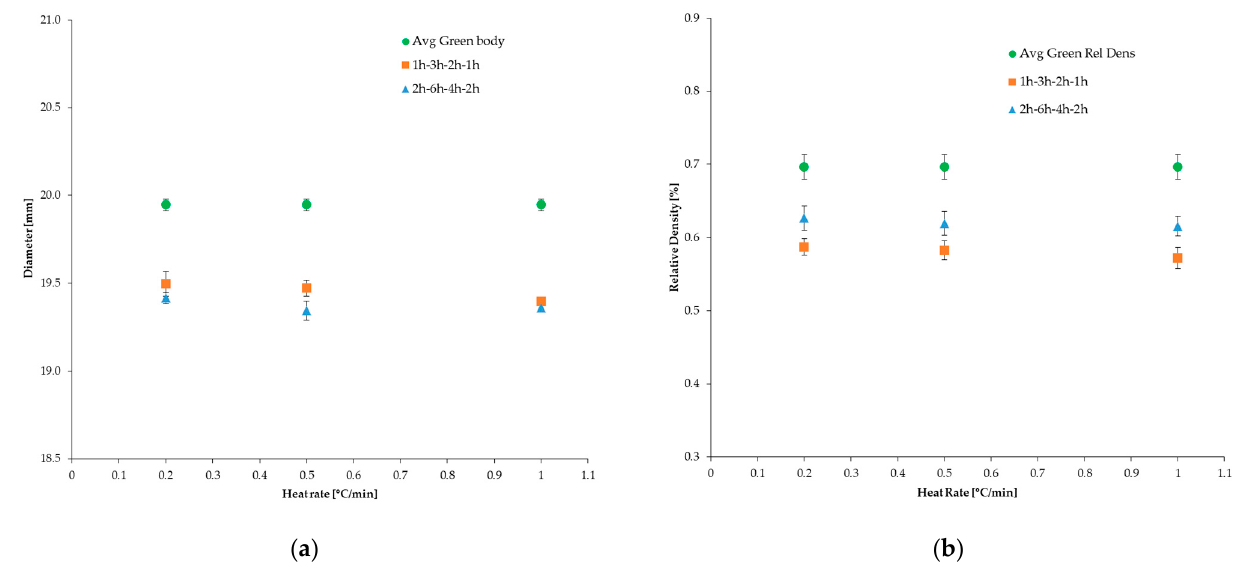
Figure 17. Diameter dimension ( a ) and measured density ( b ) of the debound discs.